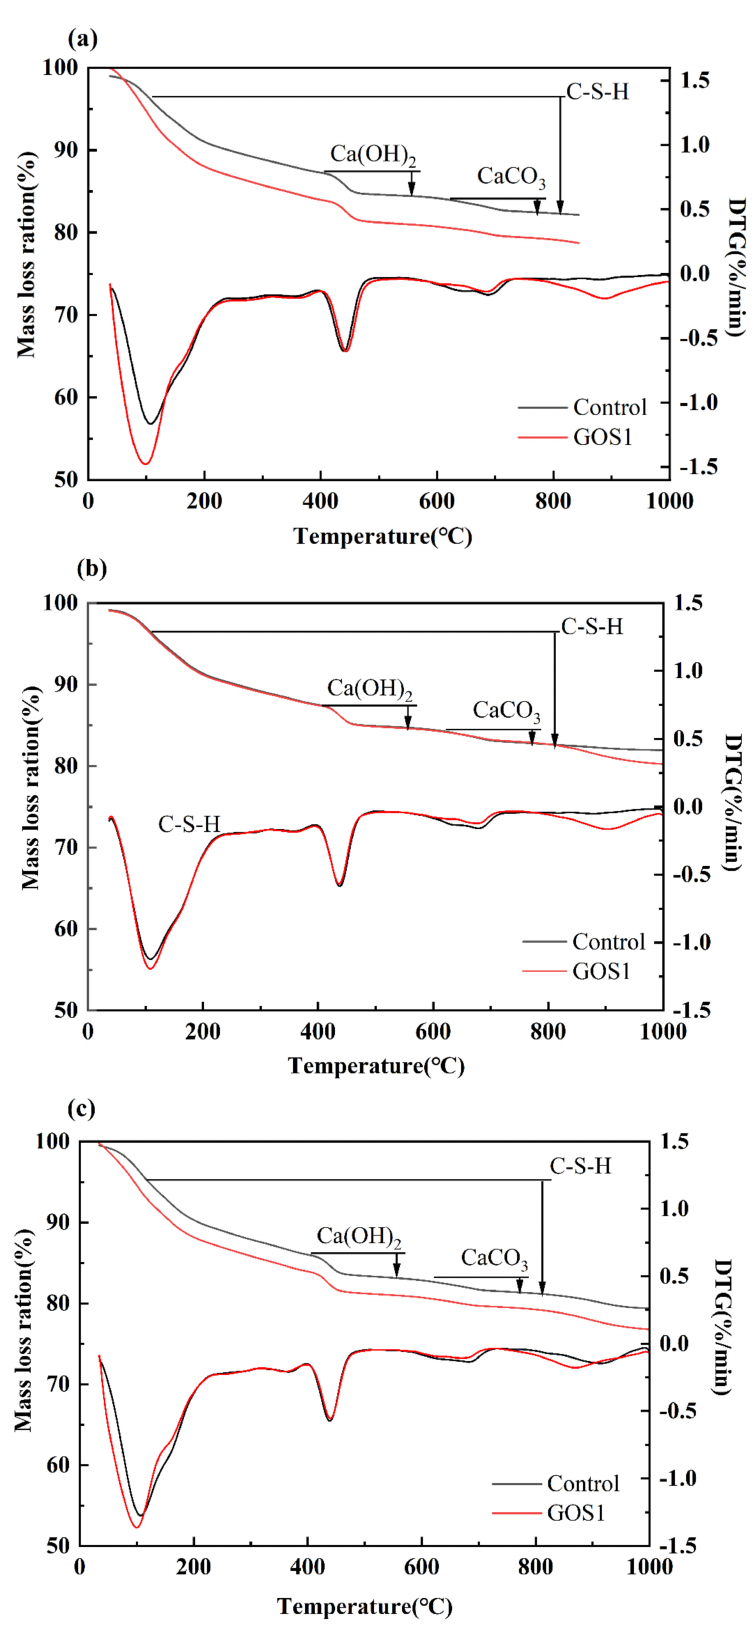
Figure 12. The TG − DTA curves of the control group and the GOS1 experimental group at different hydration ages: ( a ) 3 d. ( b ) 7 d. ( c ) 28